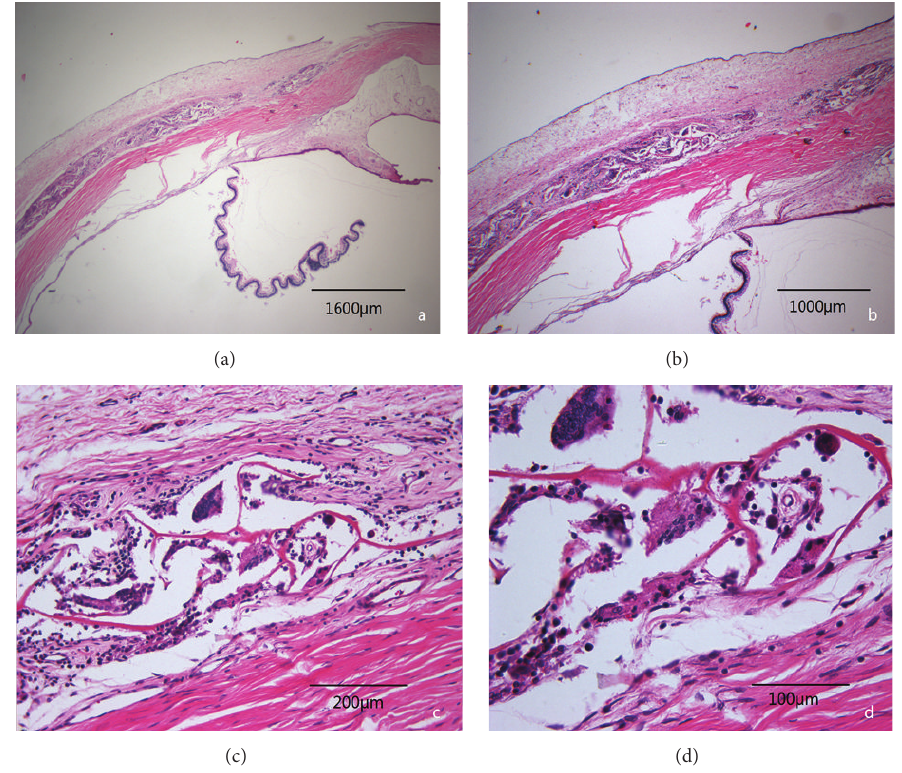
Figure 6: Subconjunctiva hyperblastosis composed of fibroblasts, small vessels, and inflammatory cells had been observed in the control group; the biomaterials (Ologen) had already degraded. Hematoxylin-Eosin staining, (a) × 25. (b) × 40. (c) × 200. (d) × 400.